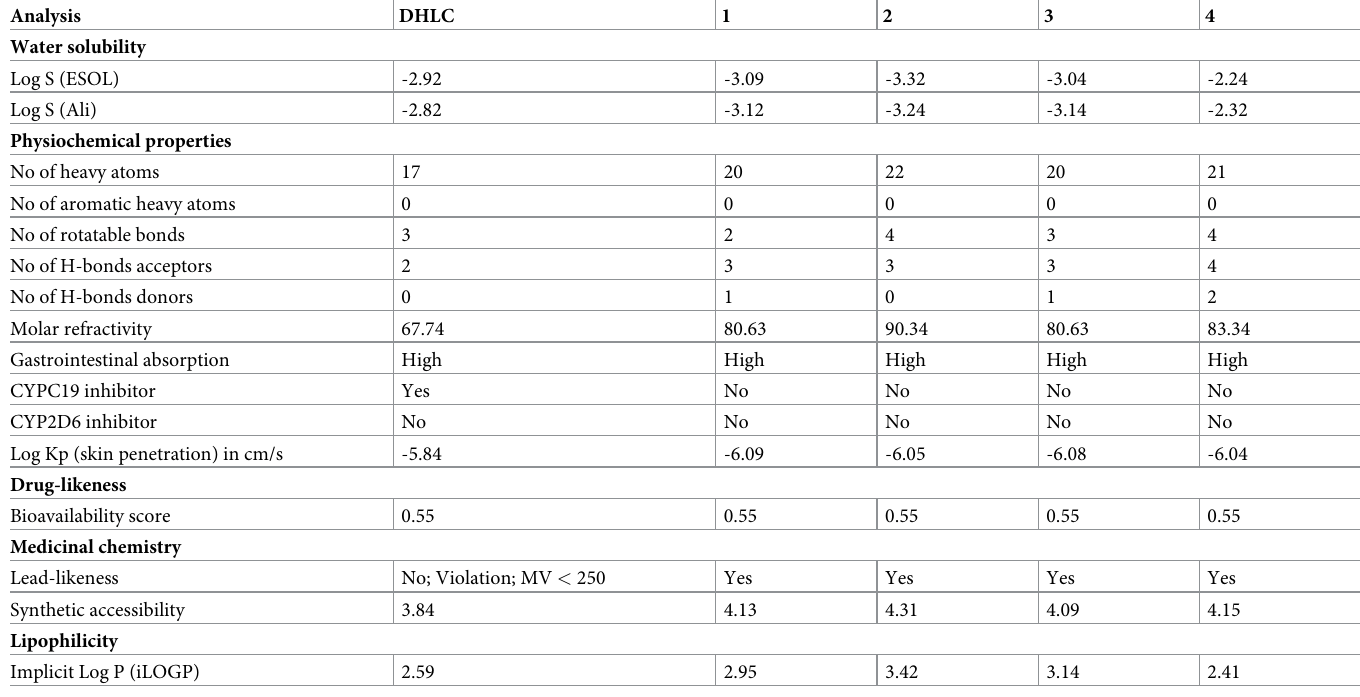
Table 3. The ADME properties of cytotoxic